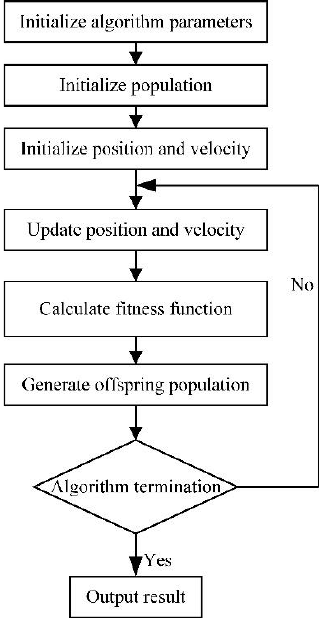
Figure 3. The flow chart of traditional PSO.